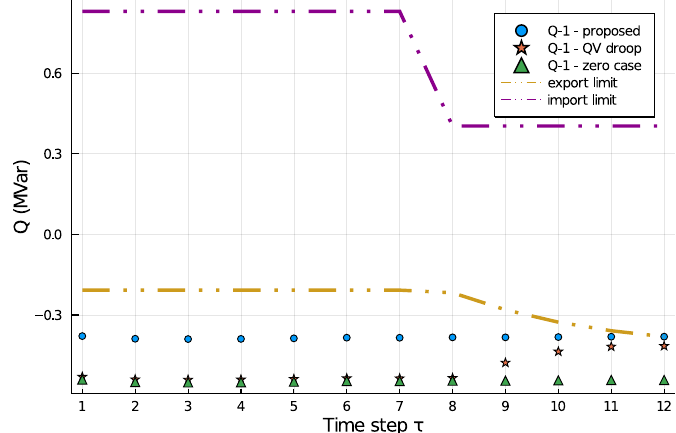
Figure 8. Evolution of the average reactive power exchange ˆ Q 1, τ , and the corresponding im- port/export TSO requirement limits until time step τ during the 8th hour of the chosen day using the proposed method (Q-1—proposed), the QV droop (Q-1 QV droop) and the zero case (Q-1—zero case).